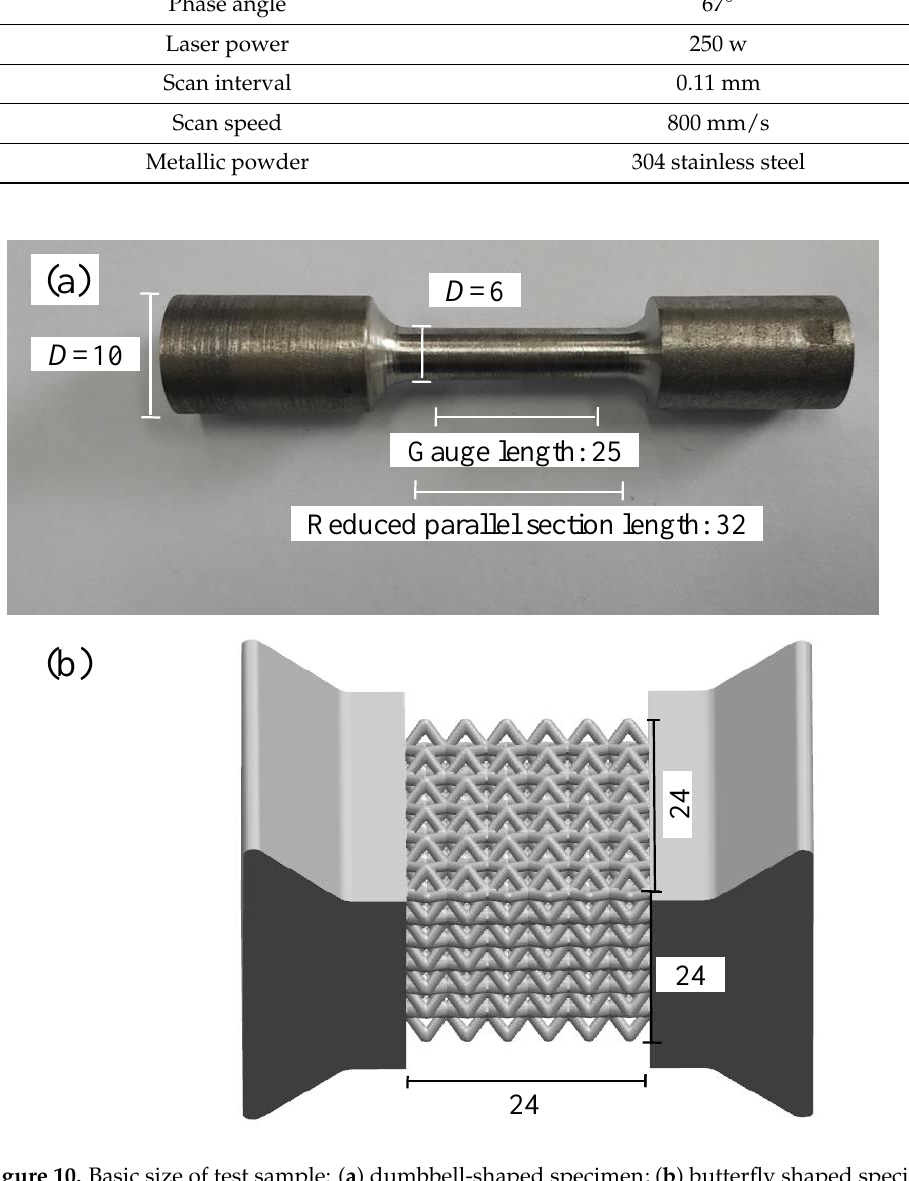
Figure 10. Basic size of test sample: ( a ) dumbbell-shaped specimen; ( b ) butterfly shaped specimen.